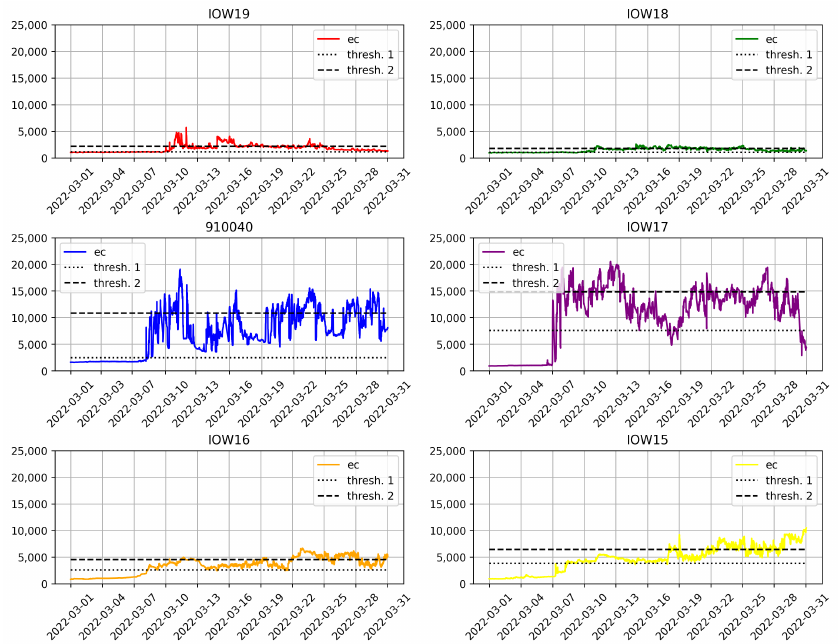
Figure 17. Variable EC25 plot during March with two thresholds: quantiles 25% and 75% of every